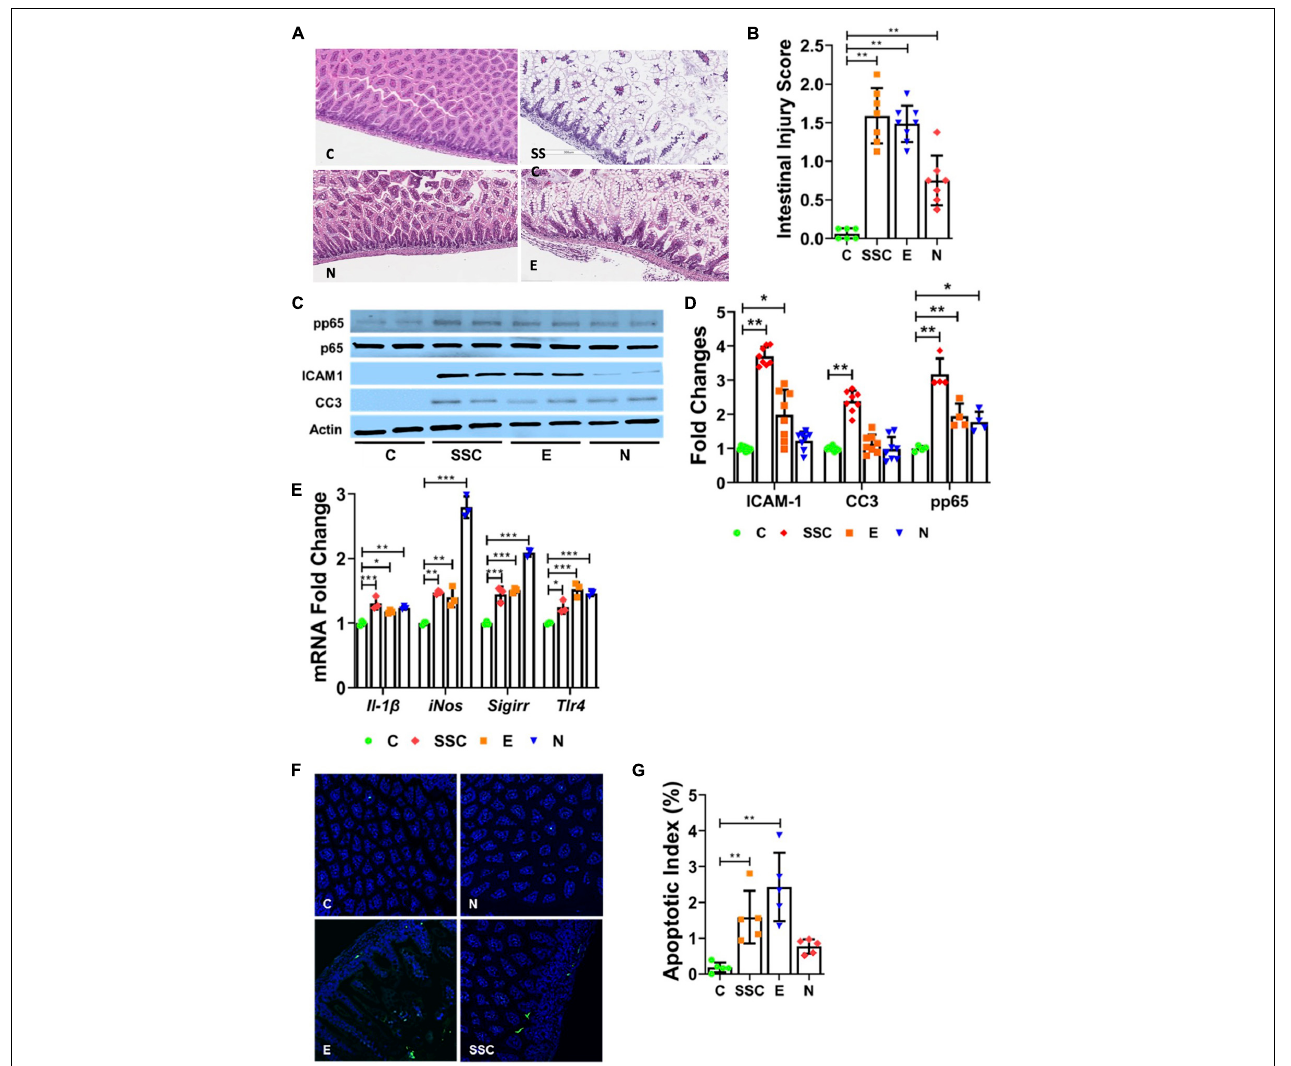
FIGURE 1 | Preterm formula elicits injury to the neonatal intestinal tract. (A) Representative histologic images of the terminal ileum from control (C) and formula-fed mouse pups (SSC, Similac Special Care; N, Neosure; E, EleCare). (B) Histologic intestinal injury scores. (C,D) Western Blot showing protein expression of phosphorylated p65, ICAM1, and CC3 from ileal tissue of control and formula-fed mouse pups. (E) Relative gene expression of IL-1 β , iNOS, SIGIRR, and TLR4 in controls vs. formula-fed pups. (F) TUNEL staining of terminal ileum of control and formula-fed groups. Green indicates TUNEL positive cells; blue, DAPI cells. (G) Apoptotic index indicating ratio of TUNEL positive cells to DAPI cells. All data are presented as mean ± SD; * P < 0.05, ** P < 0.01, *** P < 0.001 by ANOVA. n = 7–11 pups in each